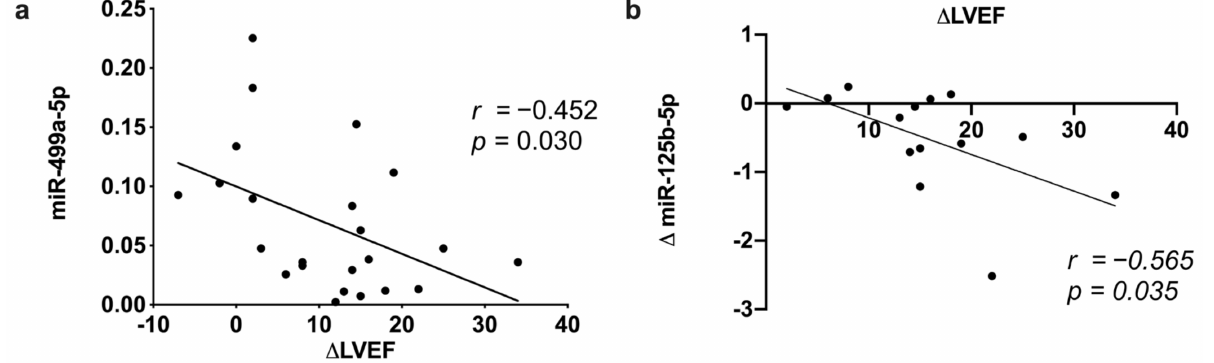
Figure 5. miRNA correlation with CRT response. Correlation between LVEF change and ( a ) baseline miR-499a levels and ( b ) follow-up miR-125b